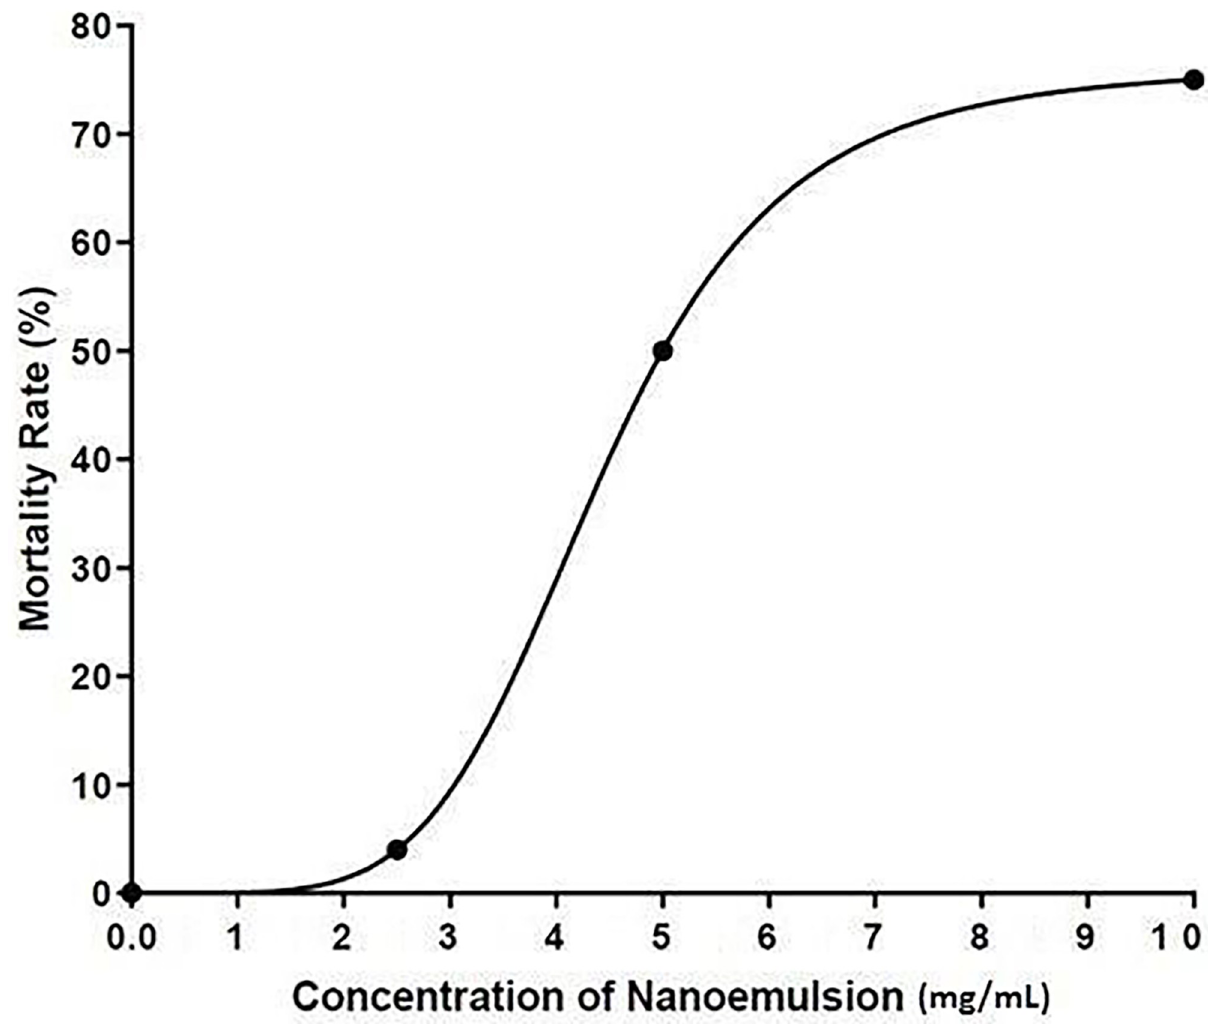
Fig 5. The effect of nanoemulsions on mortality rate of zebrafish (acute toxicity;n = 10).